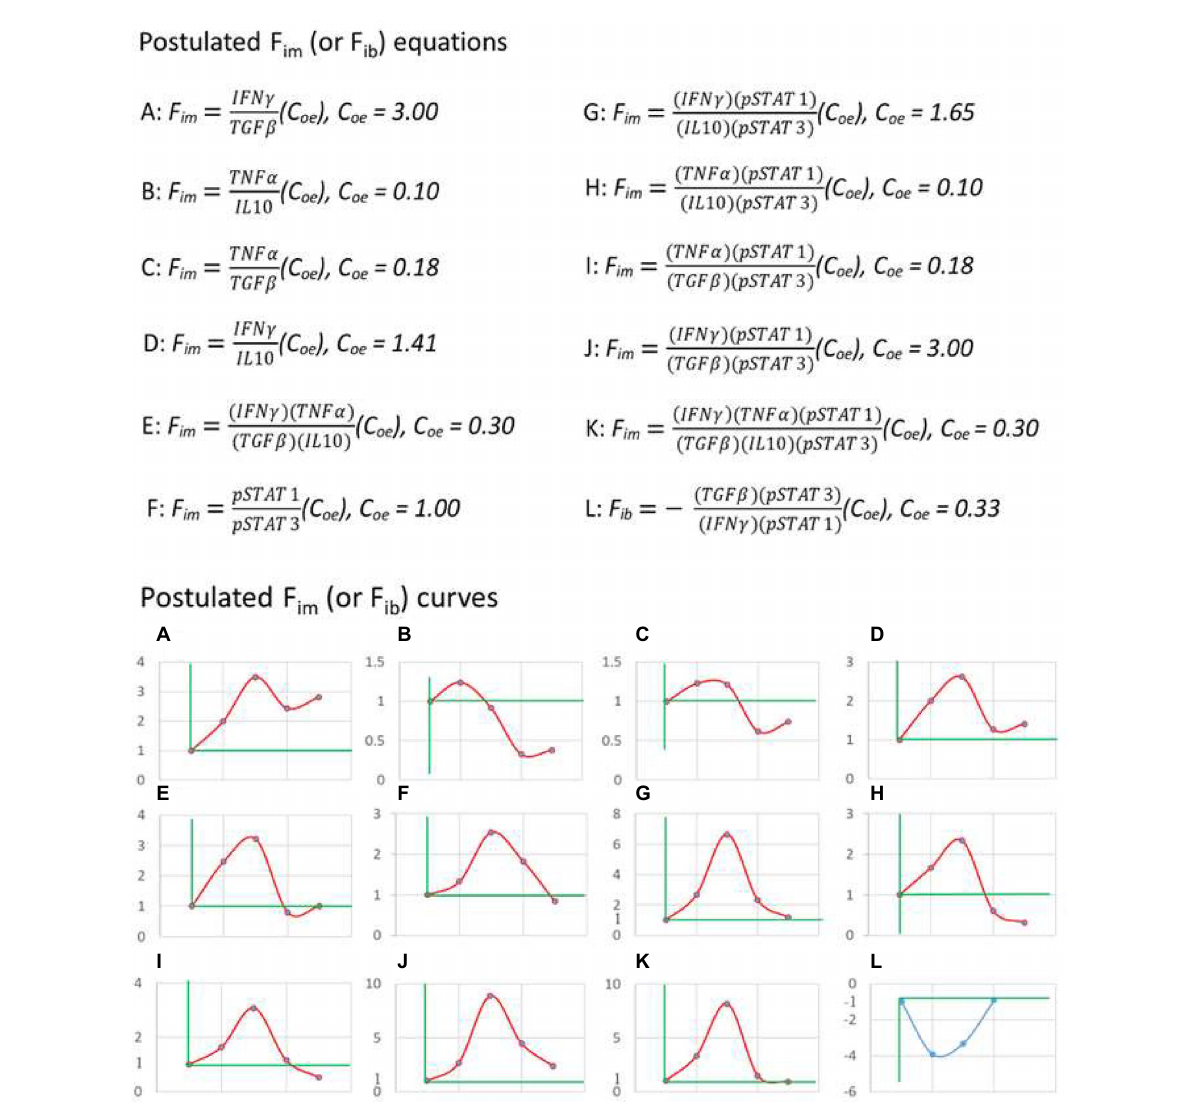
FIGURE 3 The practical immunodynamic equations were screened by the practical calculation of functional data. The process of obtaining some practical equations of immunodynamics based on the data (IFN- γ , TGF- β , TNF- α , and IL-10) of Reference (Omer et al., 2003) and the data (pSTAT1 and pSTAT3) of Reference (Shi et al., 2008). From the postulated equations (up panel) to their corresponding curves (down panel), and through the comparison and fitting of these curves with the theoretical curve shown in Figure 2B, the fitted and deduced curves (J and L, down panel) were discovered and their corresponding equations (J and L, up panel) were selected. The data used in A-K came from C57BL/6 mice infected with non-lethal Py, and the data used in L came from C57BL/6 mice infected with lethal Py. Curves A-K: The first dot of the curve represented the baseline level (F im = 1) before Plasmodium infection (on day 0), the second dot represented (the data on) day 1 after infection, the third dot represented day 7, the fourth dot represented day 14, the fifth dot represented day 21; data on day 16 in reference (Omer et al., 2003) were combined with data on day 14 in reference (Shi et al., 2008) as the data on day 14, and data on day 20 in reference (Omer et al., 2003) were combined with data on day 21 in reference (Shi et al., 2008) as the data on day 21. Curve L: The first dot represented the baseline level (F ib = − 1) before infection (on day 0), the second dot represented day 1 after infection, the third dot represented day 3, the fourth dot represented day 7; data on day 2 or day 3 in Reference (Omer et al., 2003) were combined with data on day 3 in Reference (Shi et al., 2008) as the data on day 3. Someone may ask, what values reign over C oe value in an equation, or a time curve? The answer is that the actual detected values at baseline determine the C oe value. For example, in up panel A, why C oe = 3? The answer is that, based on the data of Literature A (Omer et al., 2003), at baseline (before an immune response), IFN γ = 2 ( μ g/ml), and TGF β = 6 ( μ g/ml), thus, C oe = 6/2 = 3 (C oe = Y/X). This can ensure that F im = (2/6) (3) = 1 at